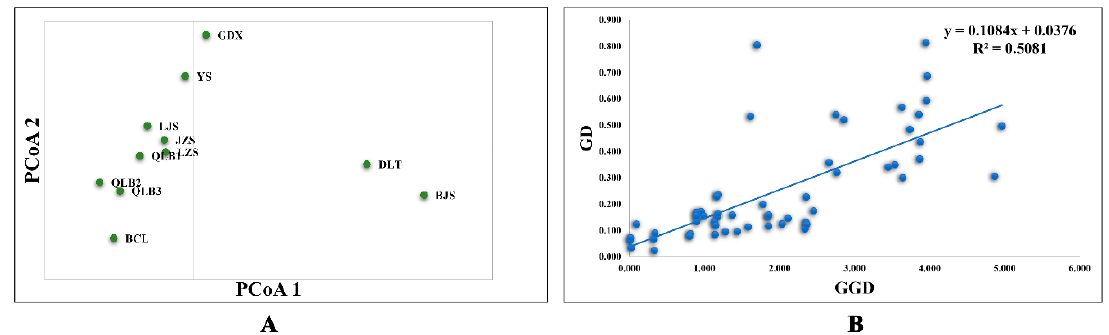
Figure 2. Principal coordinate analysis ( A ) and the plot of geographical distance against genetic distance ( B ) for R. rex subsp. rex by SSR data analysis.